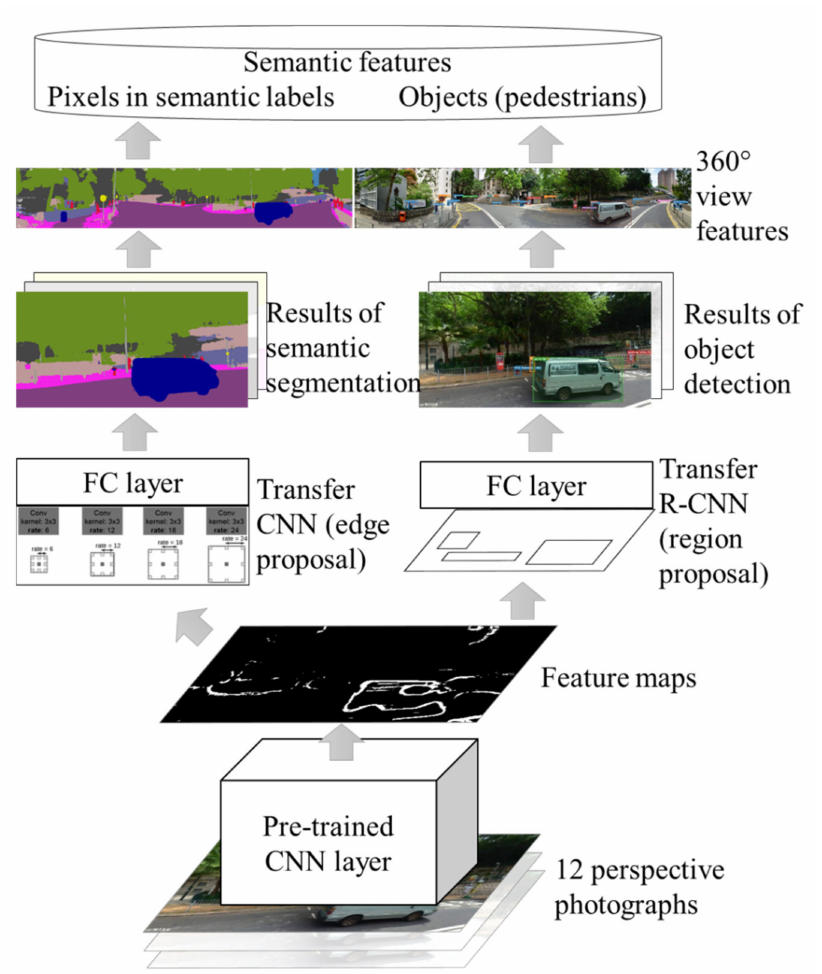
Figure 5. Methods of semantic feature extraction based on transfer deep learning in Step